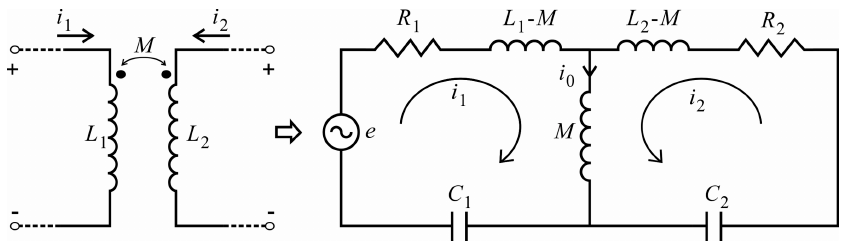
Figure 5. T type equivalent circuit of the magnetically coupled primary and secondary circuit.